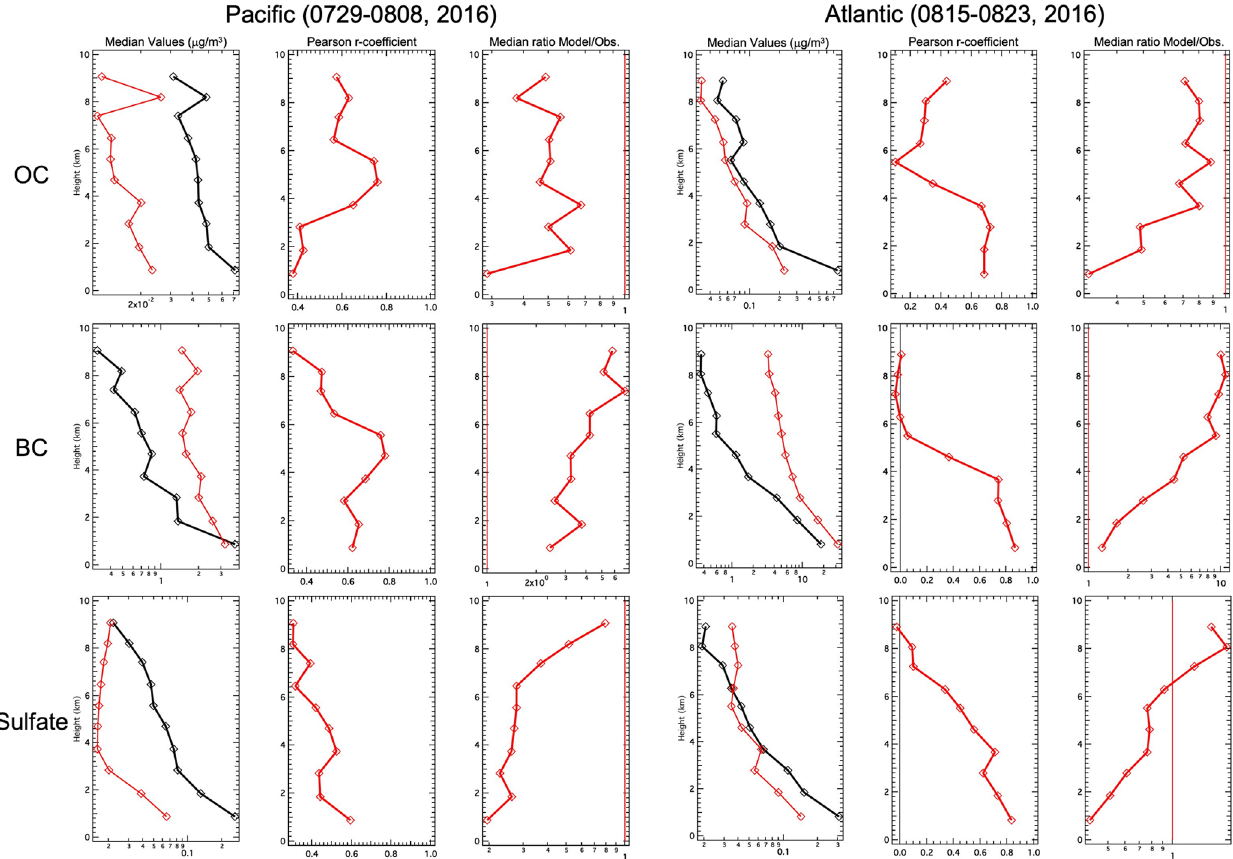
Figure 16. Vertically resolved statistical comparisons of median values (black line is ATom-1 observation, red line is GEFS-Aerosols), r coefficient, and median ratio (model/observation) for OC, BC, and sulfate along the ATom-1 DC-8 flight tracks over the Pacific (29 July– 8 August) and Atlantic (15–23